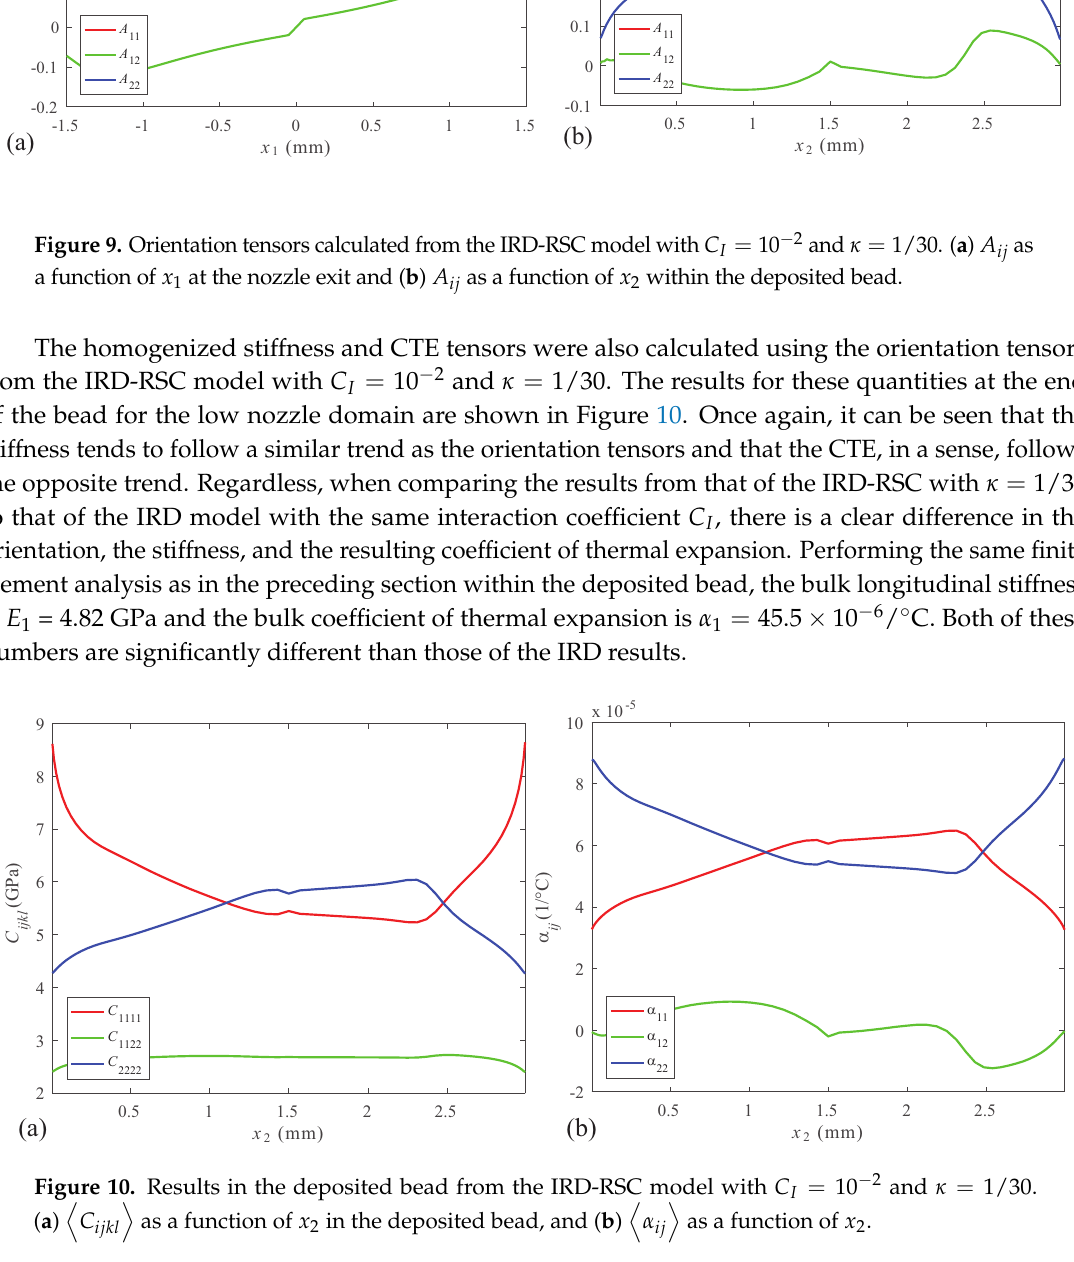
(cid:68) (cid:69) α ij as a function of x 2